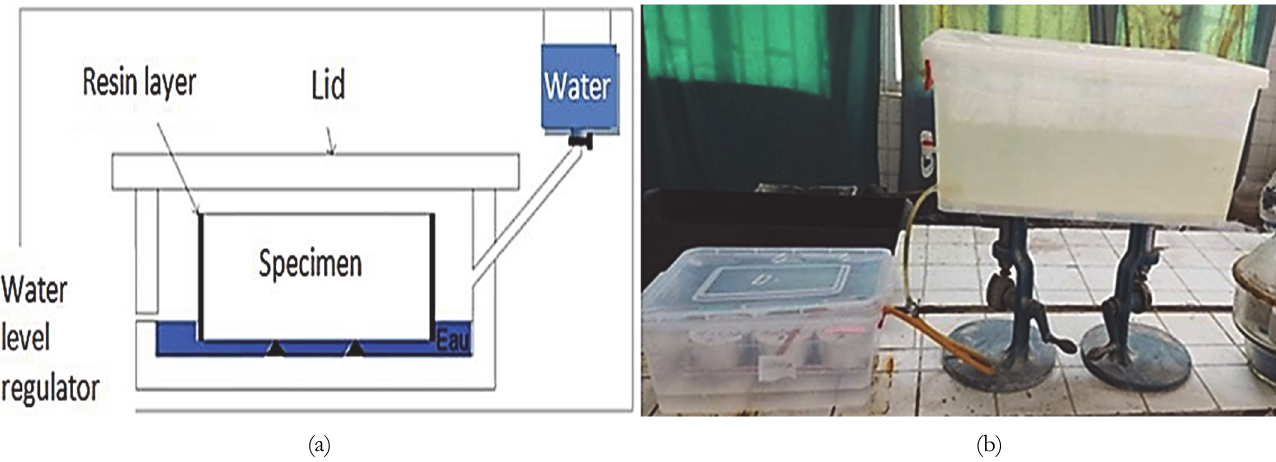
Figure 13: capillary water absorption measurement: (a) capillary water absorption test [40] and (b) capillary water absorption